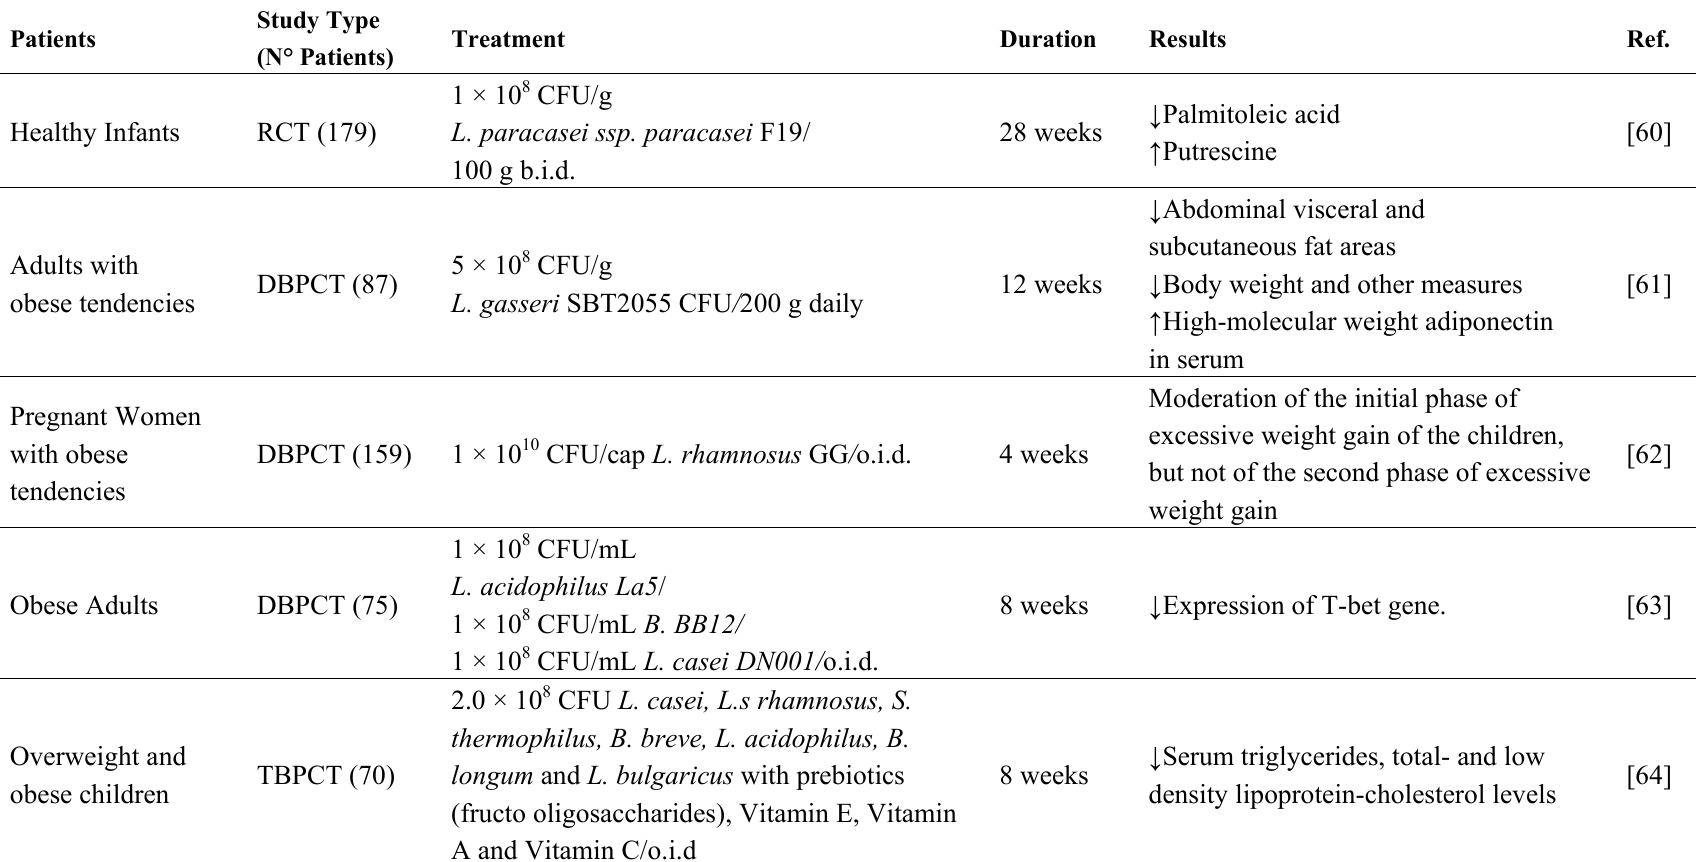
Table 3. Clinical studies of probiotics and